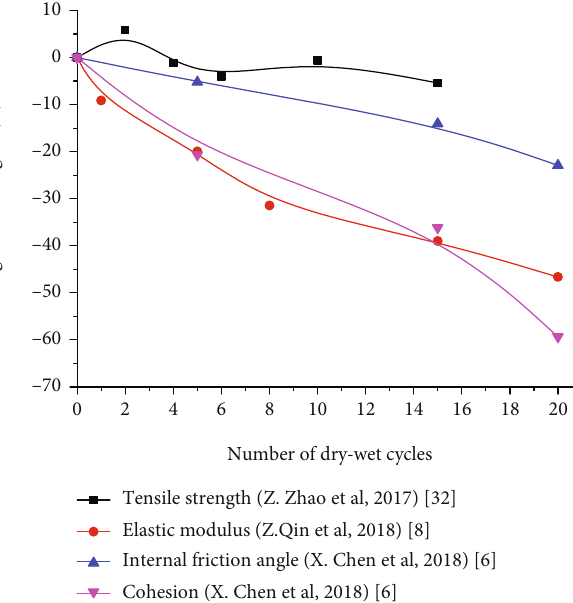
Figure 11: Degradation degree of several mechanical properties after di ff erent dry-wet